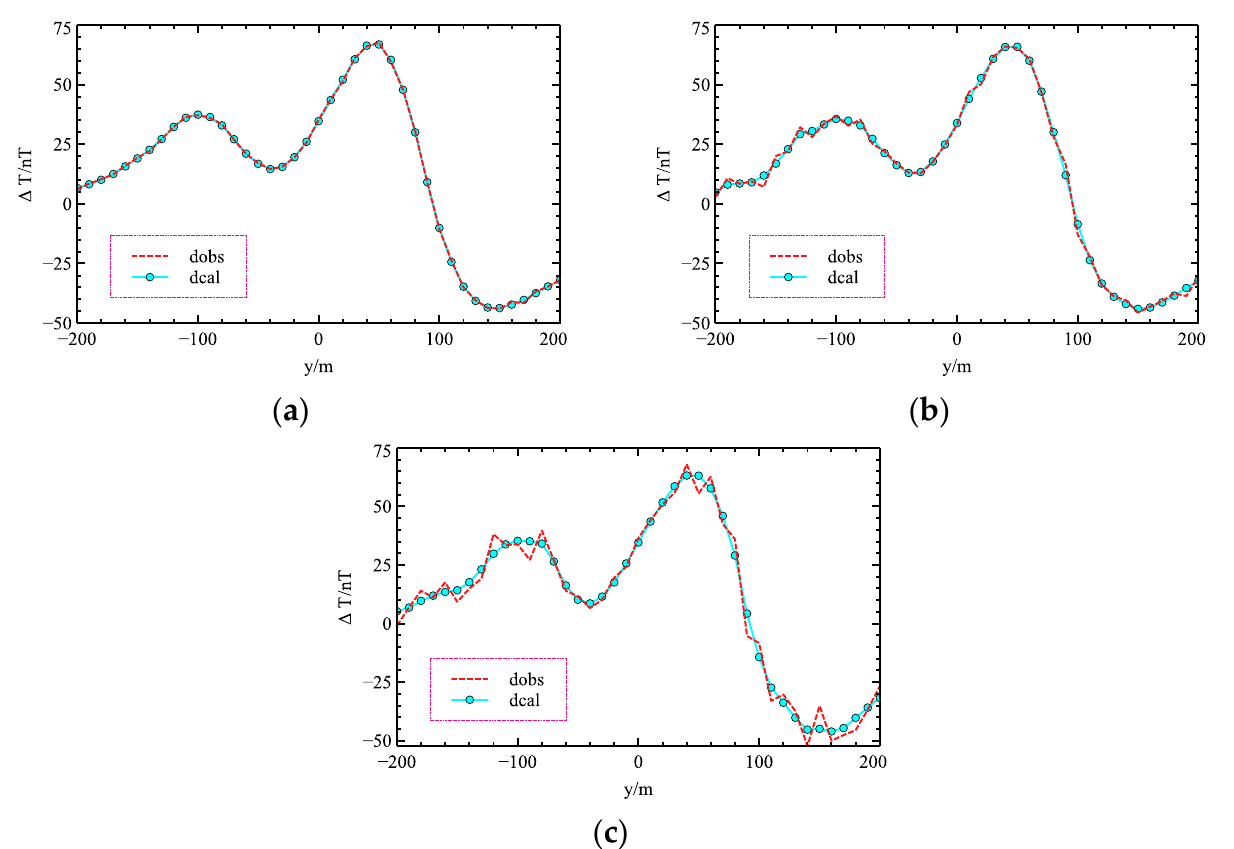
Figure 12. The inversion results with different noise level. ( a ) 1% noise, ( b ) 5% noise, ( c ) 10% noise.